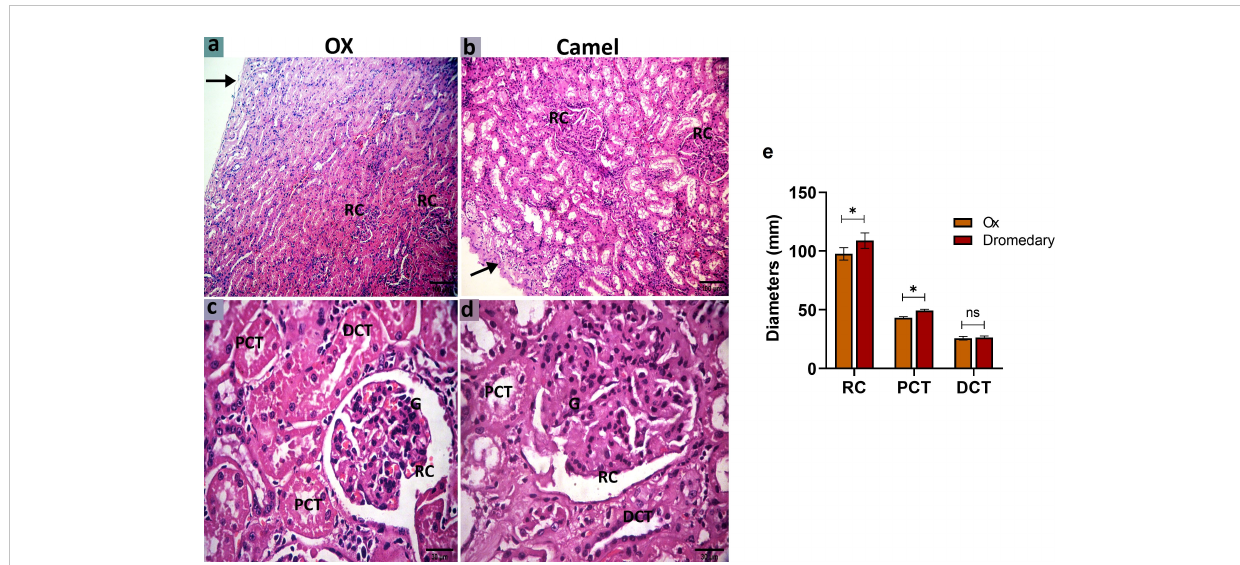
FIGURE 7 Histologic sections of the oxen and dromedary kidney show that the dromedary kidney contains larger and wider RCs and PCTs. The renal cortex of the oxen and dromedary (a and b, respectively). (A) a thinner capsule (arrow) and smaller renal corpuscles (RCs) in the ox. (B) a thicker capsule (arrow), and larger RCs in the dromedary. scale bar, 100 m m; hematoxylin and eosin stain. The renal cortex of the oxen and dromedary (c and d, respectively). (C, D) RC, glomerulus-G, proximal convoluted tubules-PCT, and distal convoluted tubules-DCT. Scale bar, 30 m m; hematoxylin and eosin stain. (E) Morphometry analysis for diameters of RC, PCT, and DCT. Data shown are represented as mean ± SD.* p